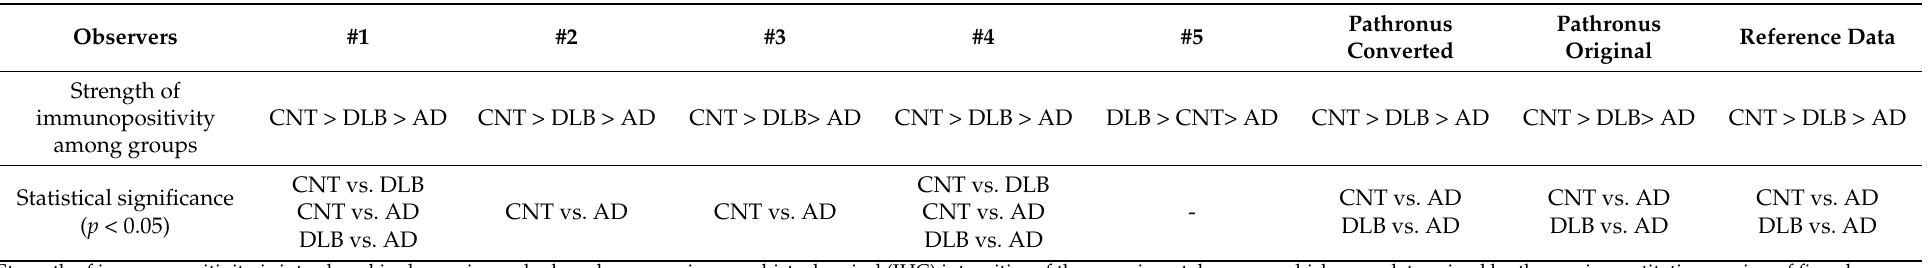
Table 3. Decreasing order of experimental groups based on the mean intensities assessed by semi-quantitative scoring, Pathronus original analysis, and reference data.